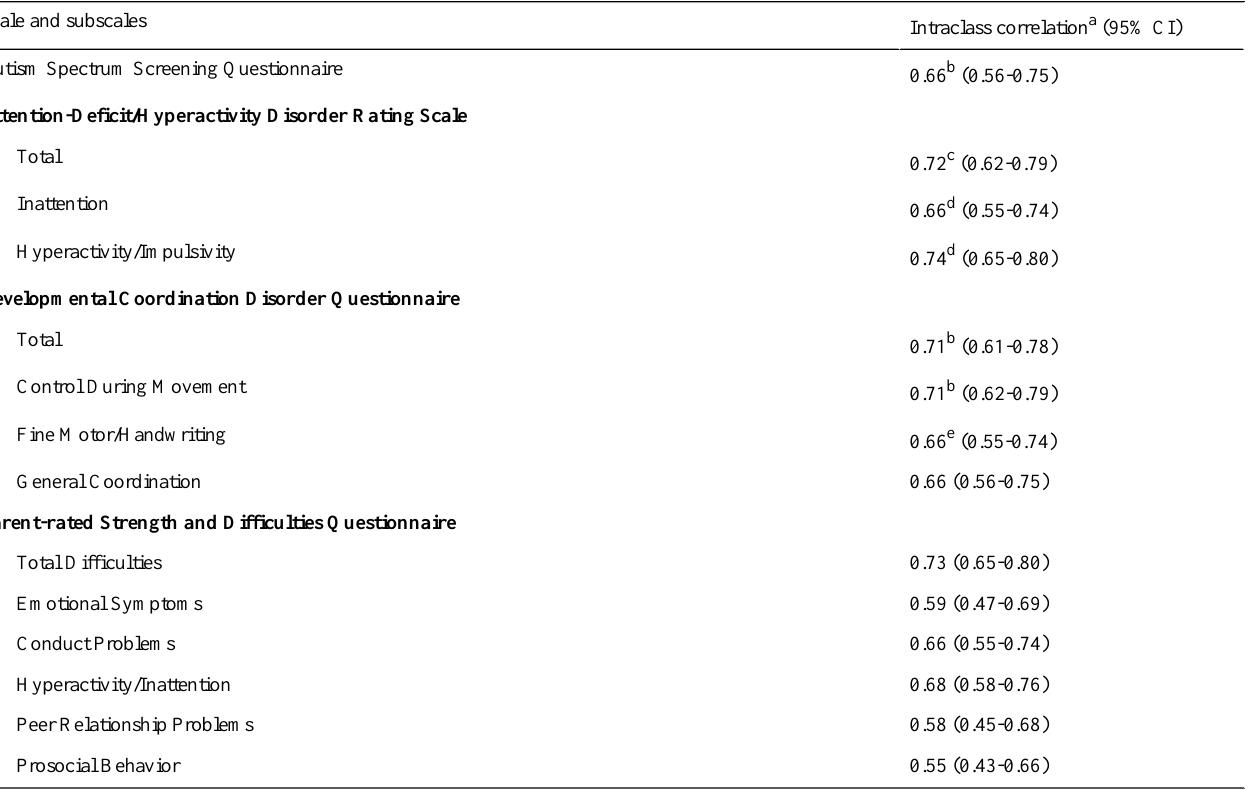
Table 3. Intraclass correlation coefficients between the web-based and paper formats of the ASSQ, ADHD-RS, DCDQ, and P-SDQ (N=140).